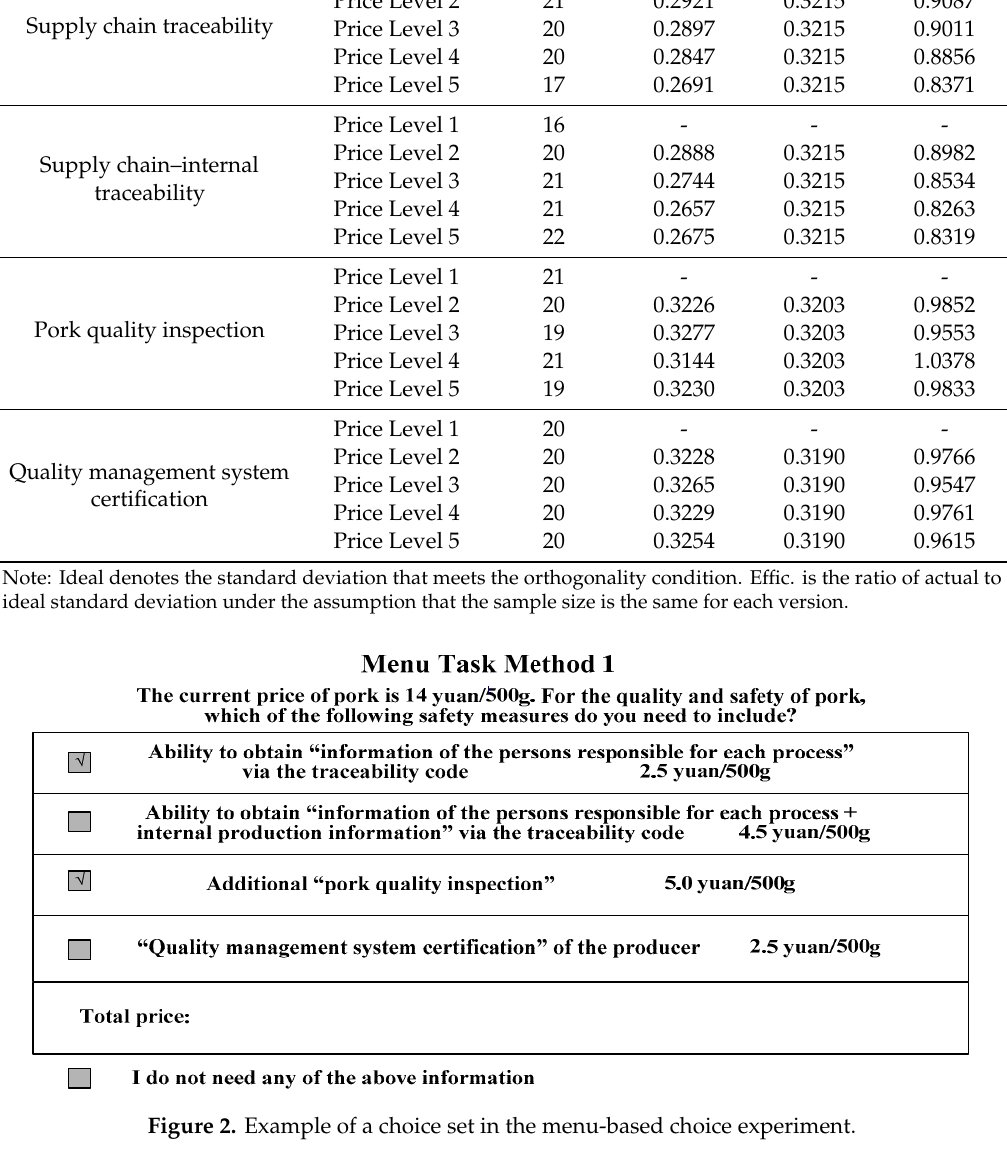
Table 4. Efficiency test results of the attributes and levels design.